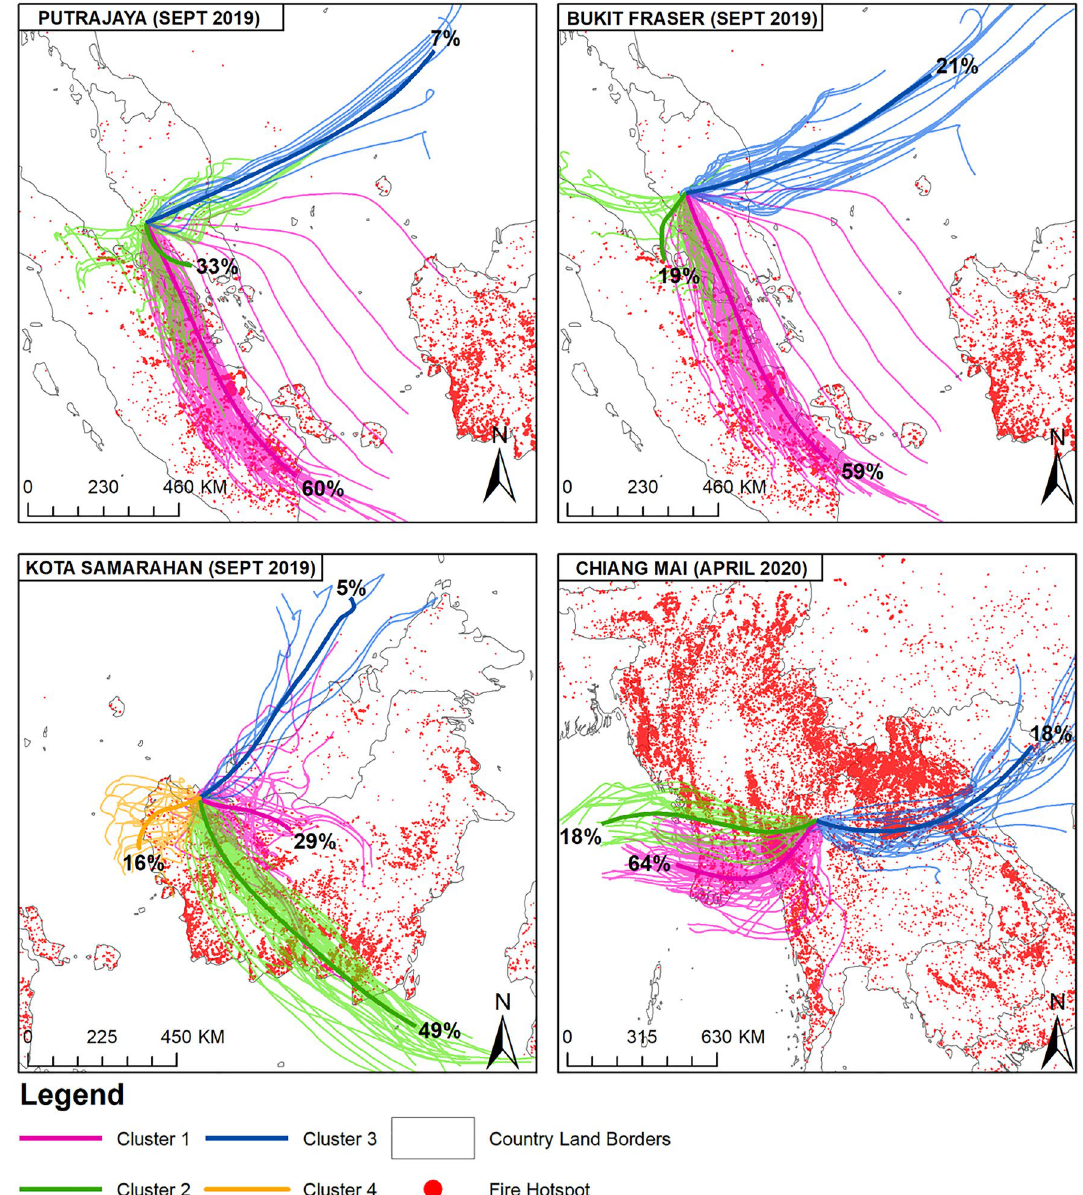
Figure 4. Cluster trajectory and hotspots distribution during haze days in Putrajaya, Bukit Fraser, Kota Samarahan and Chiang Mai. The maps were made using ArcMap v10.8.1 geospatial processing program http:// www. esri. com and MODIS fire hotspot was downloaded from Aqua and Terra fire hotspot (https:// firms. modaps. eosdis. nasa. gov/ map/#d: 24hrs;@0. 0,0. 0,3z). The map was produced by the